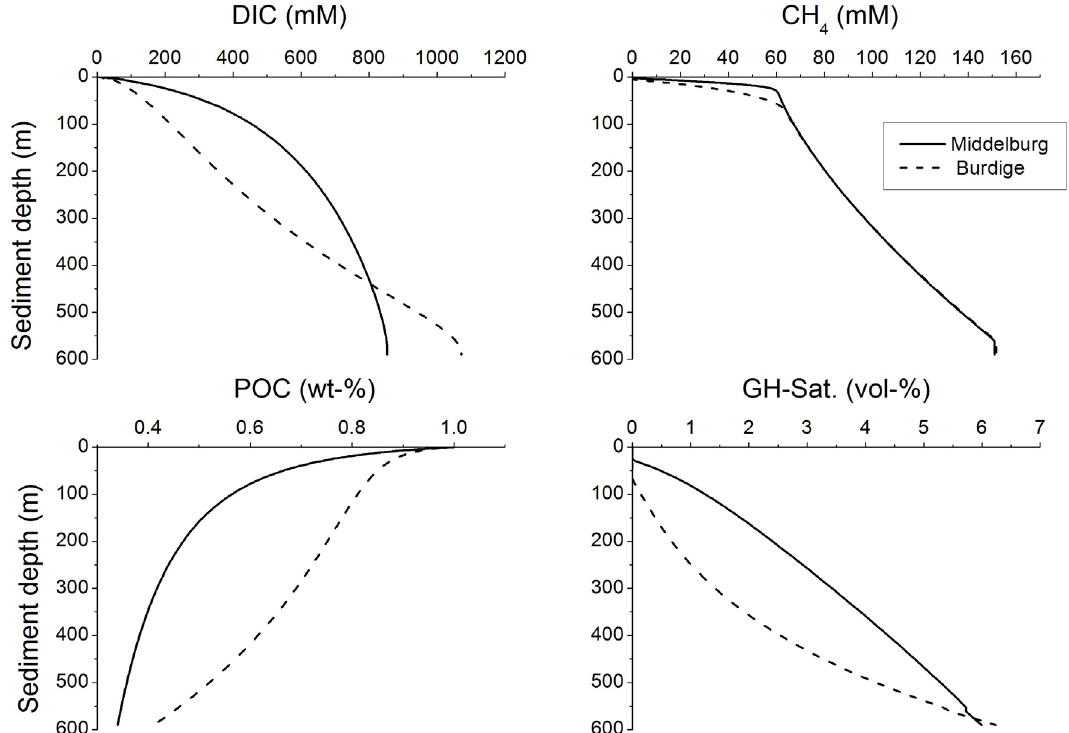
Figure 28. Concentrations of dissolved inorganic carbon (DIC), dissolved methane (CH particulate organic carbon (POC) and methane hydrate saturation (GH-Sat.) calculated by integrating the kinetic rate laws introduced by Middelburg [Equations (7,8)] and Burdige [Equation (35)] into the reaction-transport